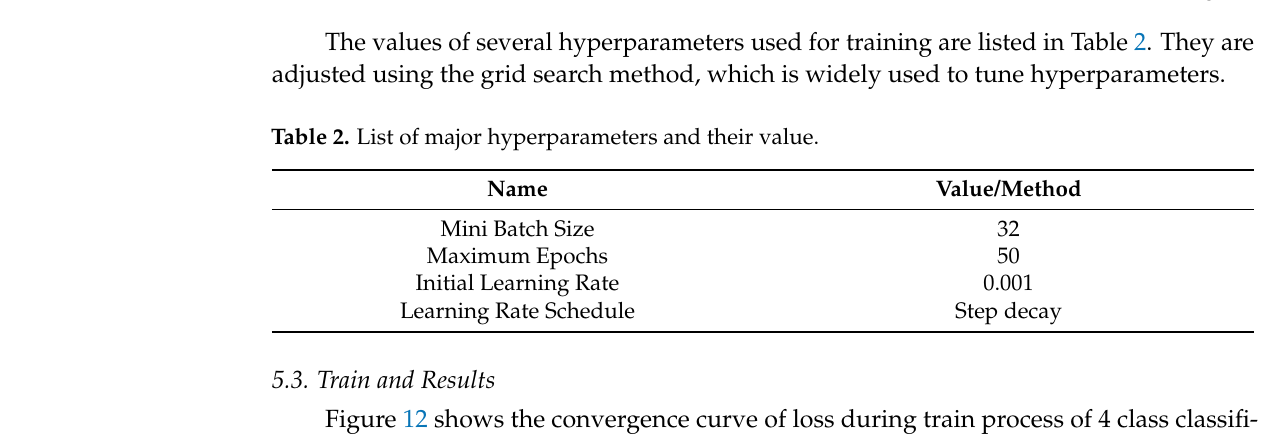
Figure 11. CNN architecture used for classification of road surfaces and tires based on TPIN signal.